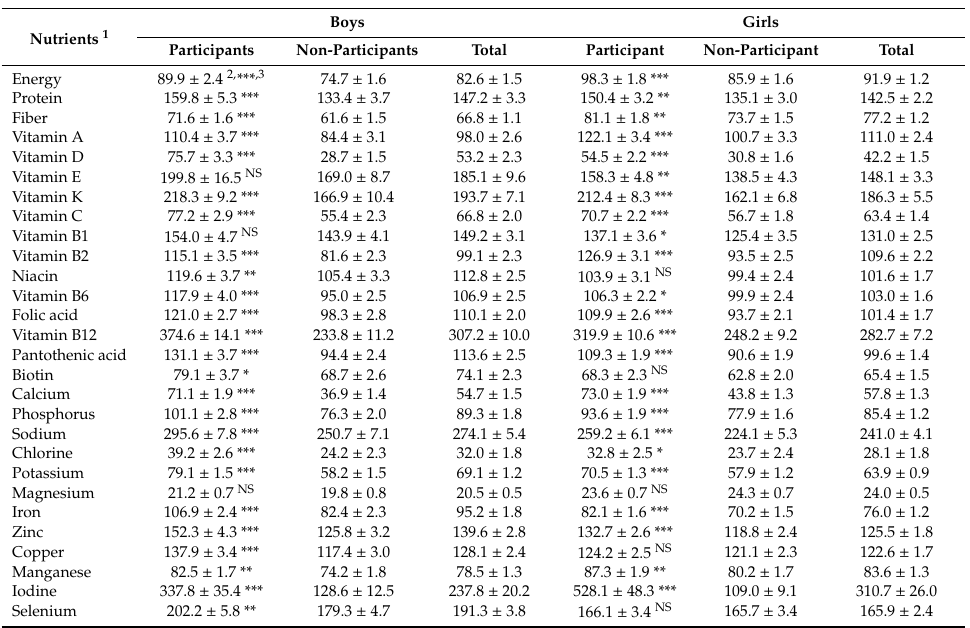
Table 4. Percentages of daily nutrient intake compared to KDRIs of participants and non-participants in the school milk program in South